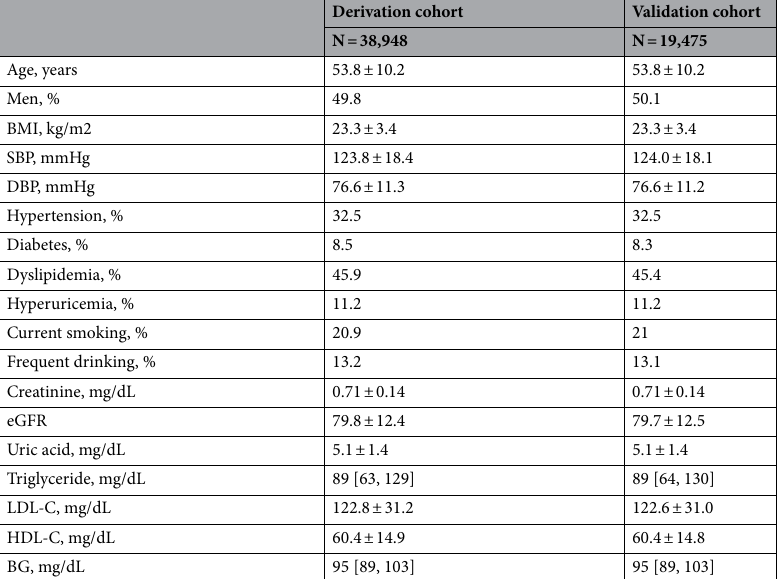
Table 1. Baseline characteristics of study population in the derivation and validation cohorts. Continuous variables are expressed as mean ± standard deviation, except for triglyceride and blood glucose levels, which are expressed as median [1st quartile, 3rd quartile]. Categorical variables, including cardiovascular risk factors and lifestyle variables, are expressed as number of subjects and proportions (percentages). BMI body mass index, SBP systolic blood pressure, DBP diastolic blood pressure, eGFR estimated glomerular filtration rate, LDL-C